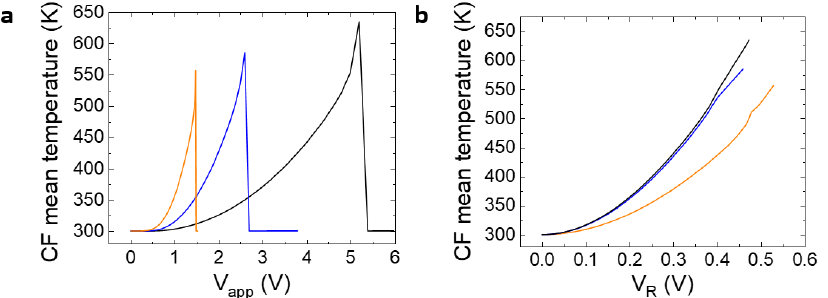
Figure 3. ( a ) Average CF temperature along the simulated I-V curves during the reset process versus the device applied voltage, ( b ) average CF temperature versus V R . Three CF radii are considered (1 nm, 2 nm, 3 nm) for cycles #1 (orange line), #2 (blue line), and #3 (black line).